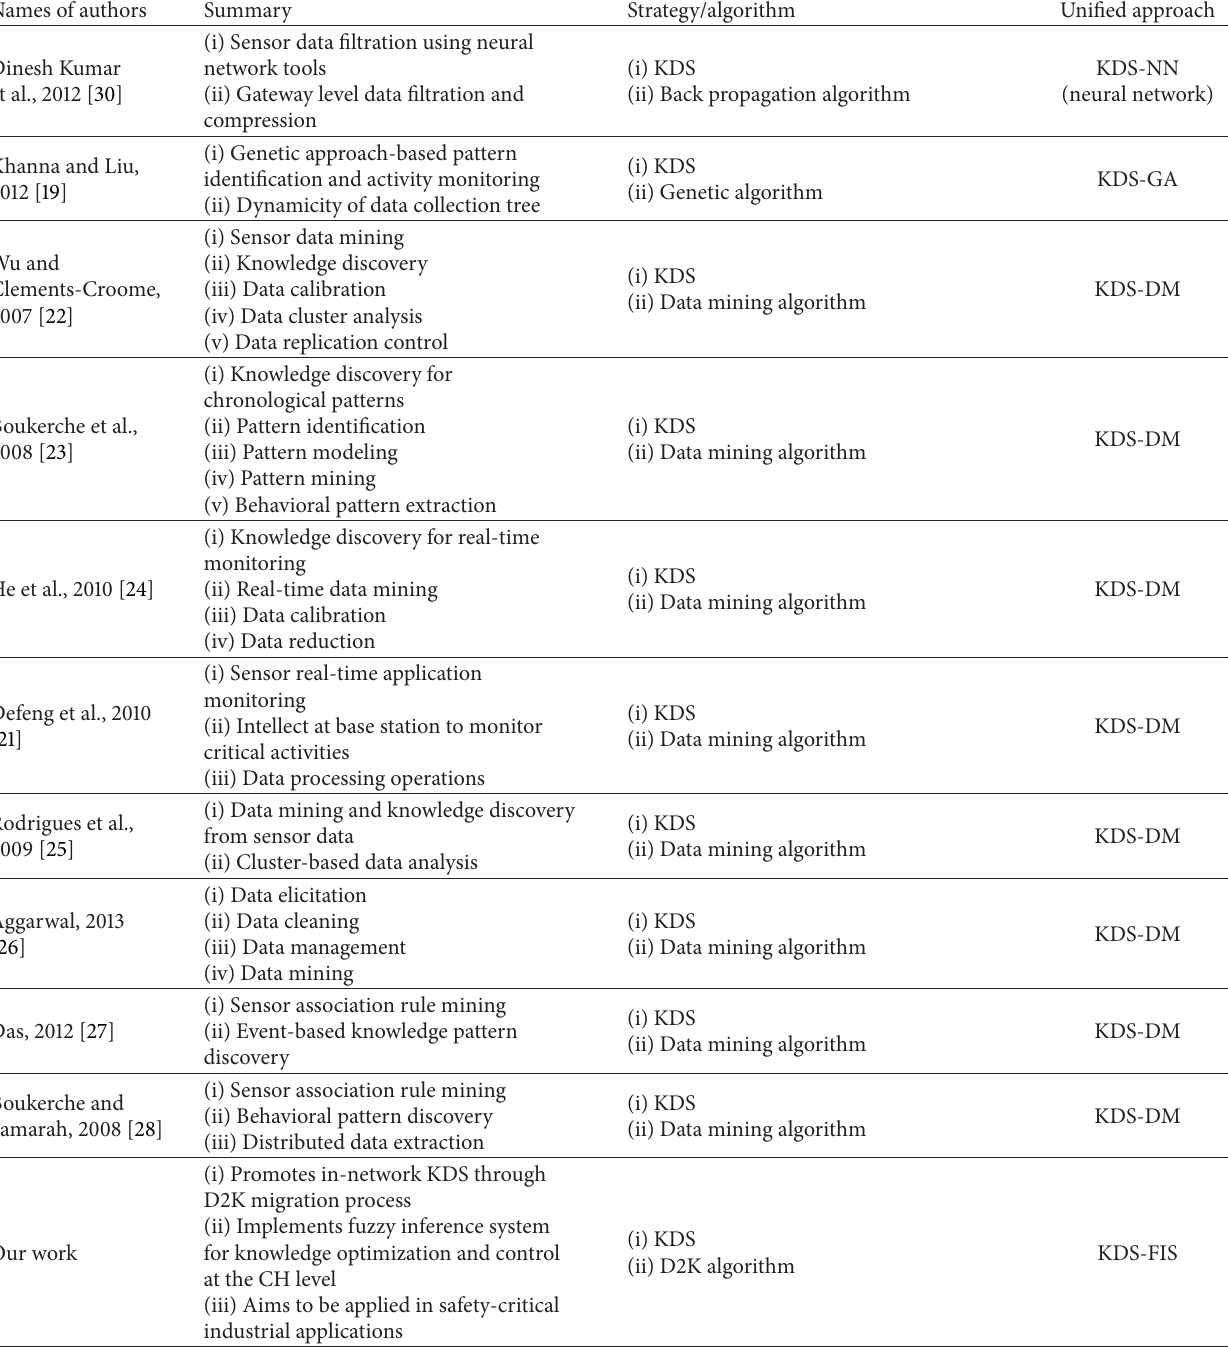
Table 1: Comparison of various works based on the implemented strategies and algorithms for sensor